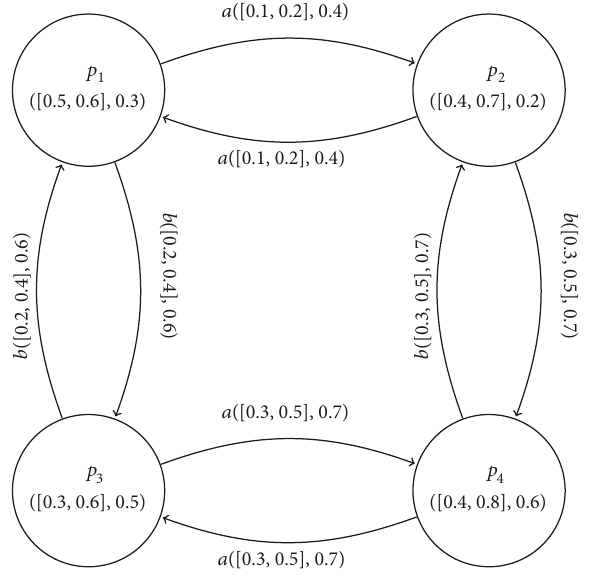
Figure 12: A subsystem ̂𝜑 of cubic fssm T .